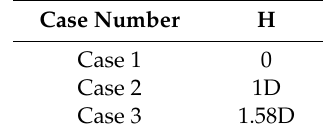
Figure 1. Schematic of the computational domain for the case with di ff erent step heights. Table 2. Step height of di ff erent cases.